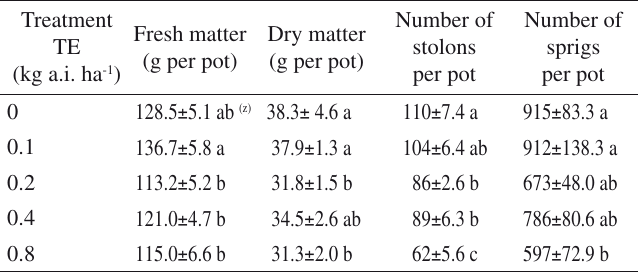
Table 1 - Aerial biomass production in Patriot bermudagrass treated with different doses of TE (kg a.i. ha- 1 ) seven weeks after treatment Treatment